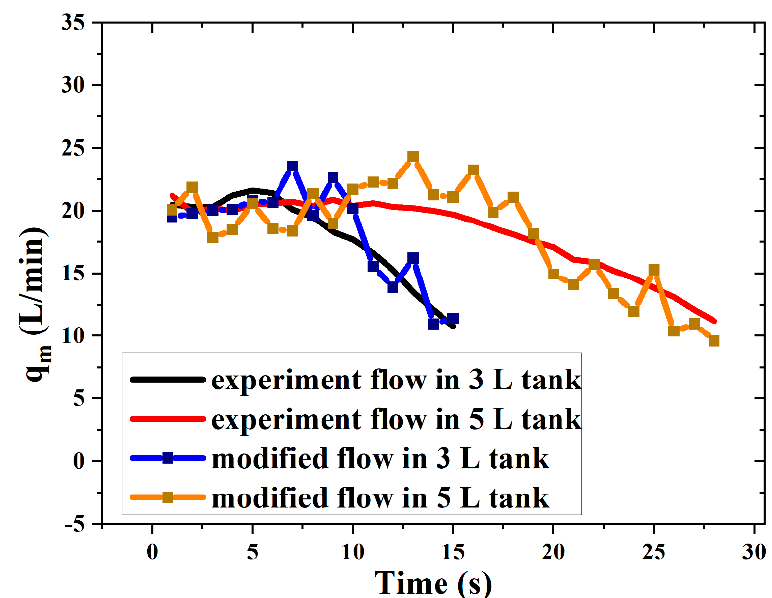
Figure 11. Fitting results of flow index model.